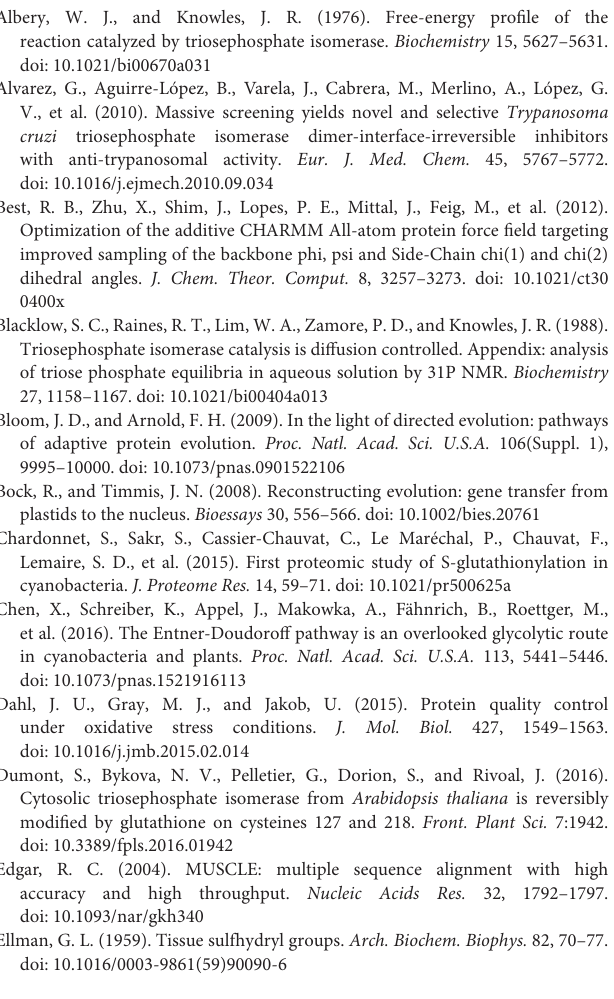
Figure S1 | Purification of SyTPI by IMAC. Fifteen percent SDS-PAGE stained with Coomassie blue showing the IMAC purification step of SyTPI (A) . Crystals of